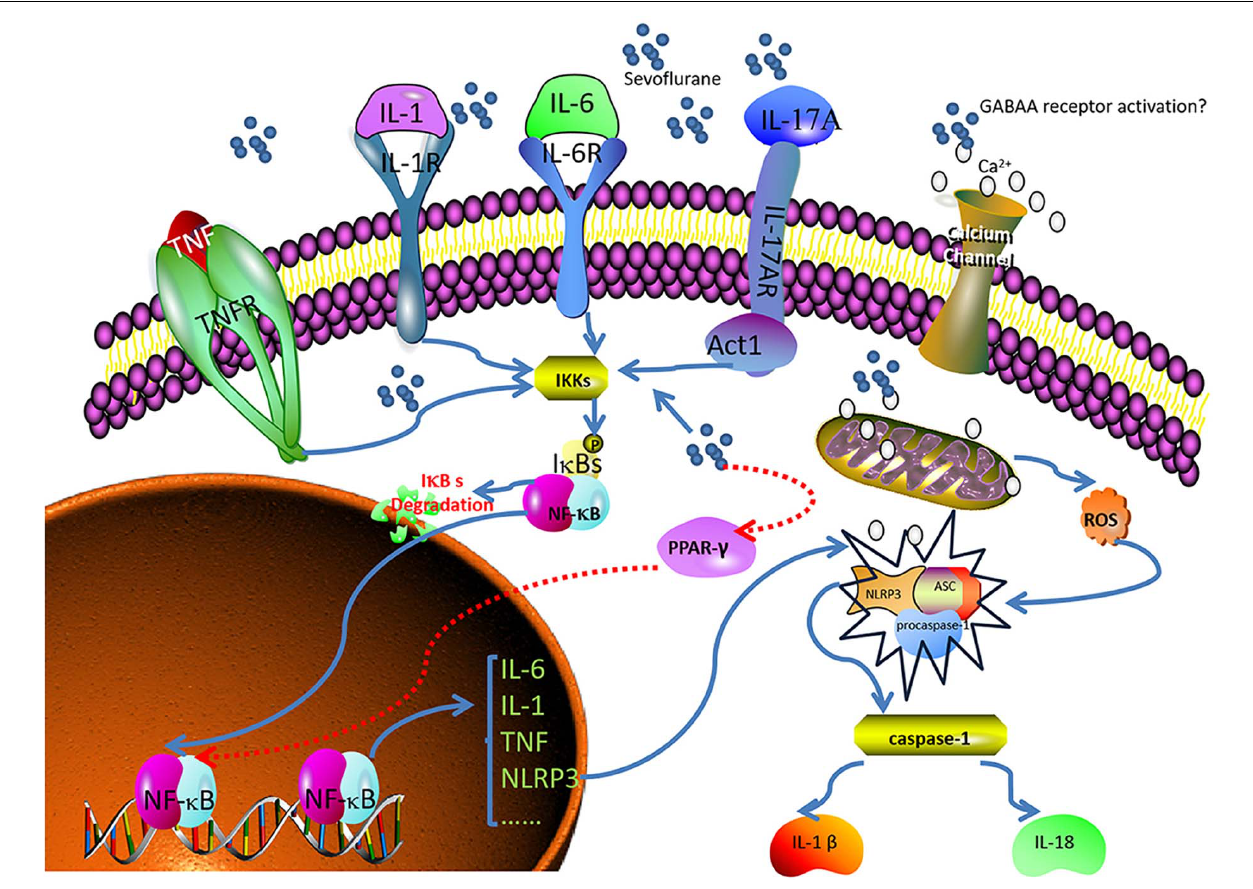
FIGURE 1 | Sevoflurane induces neuroinflammation and leads to POCD. Nuclear factor-kappa B (NF- κ B) recognizes and regulates genes related to inflammation. Peroxisome proliferator-activated receptor- γ (PPAR- γ ) exerts anti-inflammatory effects by inhibiting NF- κ B. The Nod-like receptor protein 3 (NLRP3) inflammasome regulates the maturation and release of pro-inflammatory cytokines. Sevoflurane directly penetrates the cell membrane and stimulates NF- κ B signaling. Sevoflurane downregulates PPAR- γ , increases intracellular calcium levels, induces mitochondrial injury, and increases reactive oxygen species (ROS). Calcium and ROS, in turn, activate NLRP3, and interleukin (IL)-1, IL-6, tumor necrosis factor (TNF), and IL-17 activate NF- κ